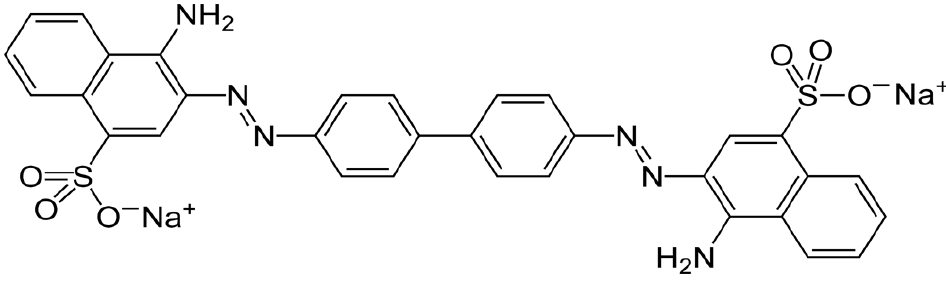
Figure 1. Structure of Congo red.